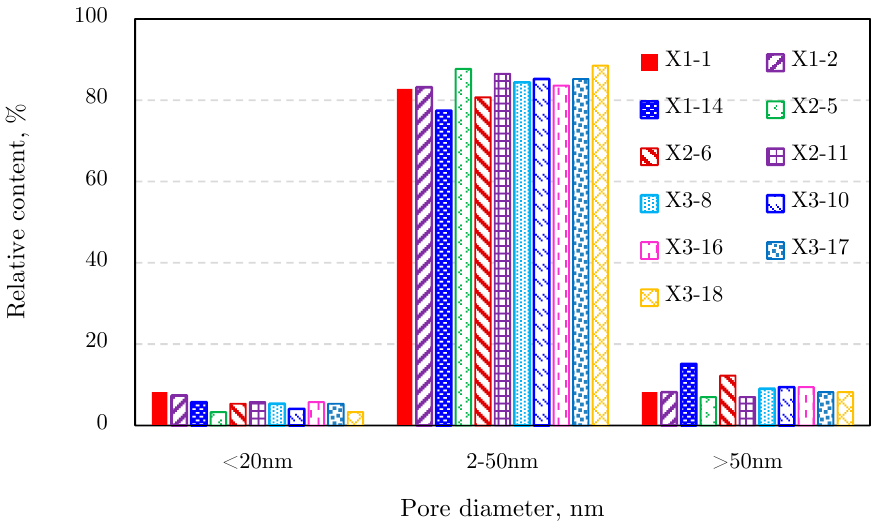
Figure 14. PSD histogram of samples from the Longmaxi Formation in the Sichuan Basin based on NMR.